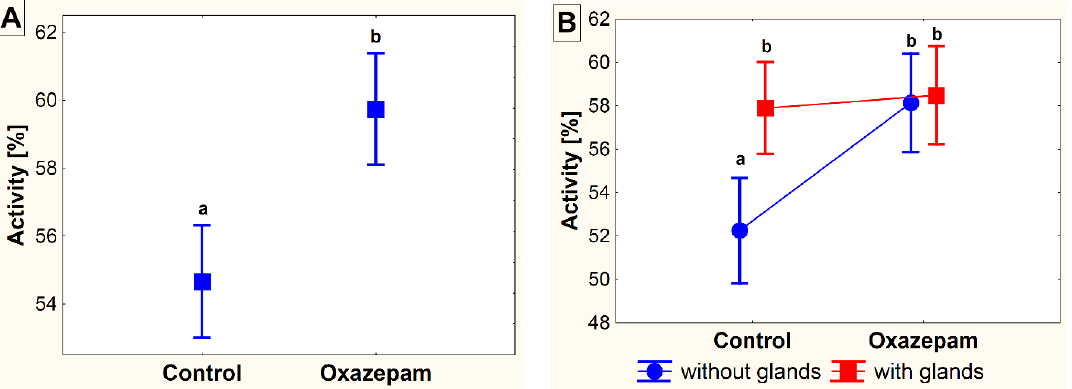
Figure 2. The activity (in %) of marbled crayfish ( Procambarus virginalis , Lyko 2017) exposed to oxazepam (~1 µg L − 1 ) and control crayfish in the conditions without available shelter ( A ). The differences detected between the groups of crayfish in accordance with the presence of developed glair glands ( B ). The different superscripts show significant differences ( α = 0.05) among groups. Data are presented as mean ± standard error of mean.